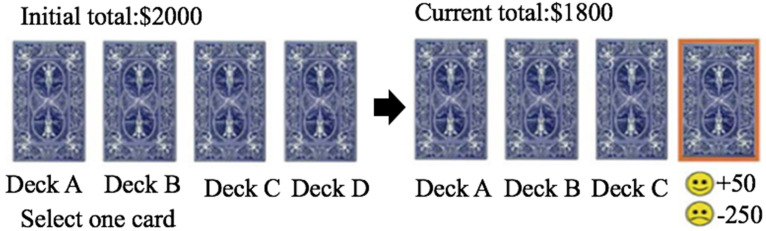
The flowchart of the IGT.